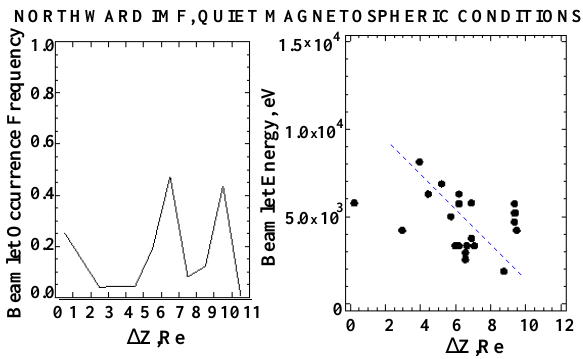
Fig. 7. Left panel: beamlet occurrence frequency versus 1Z for dis- turbed magnetospheric conditions under southward IMF. Two dis- tributions displayed by blue and green correspond to two branches of energy profile shown in the right panel. Right panel: Scatterplot of beamlet energy versus 1Z . Two different beamlet populations are marked by blue and green.